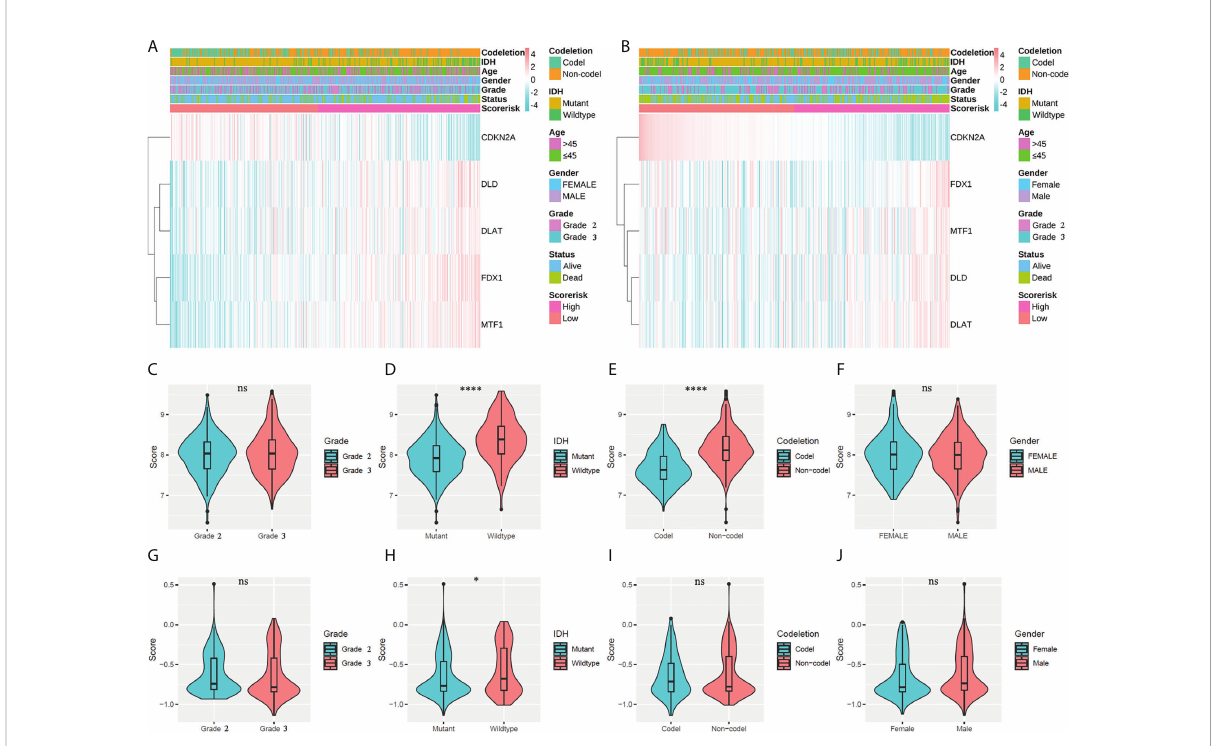
FIGURE 4 Associations between risk scores and clinicopathological factors. (A) Heatmap of the correlation between risk scores and clinicopathological features in the TCGA cohort. (B) Heatmap of the correlation between risk scores and clinicopathological features in the CGGA cohort. (C – F) Violin plot of the distribution of risk scores in patients strati fi ed by WHO class, IDH status, 1p/19q codeletion status, and gender in the TCGA cohort. **** P < 0.0001; ns, not signi fi cant. (G – J) Violin plot of the distribution of risk scores in patients strati fi ed by WHO class, IDH status, 1p/19q codeletion status, and gender in the CGGA cohort. * P < 0.05; ns, not signi fi